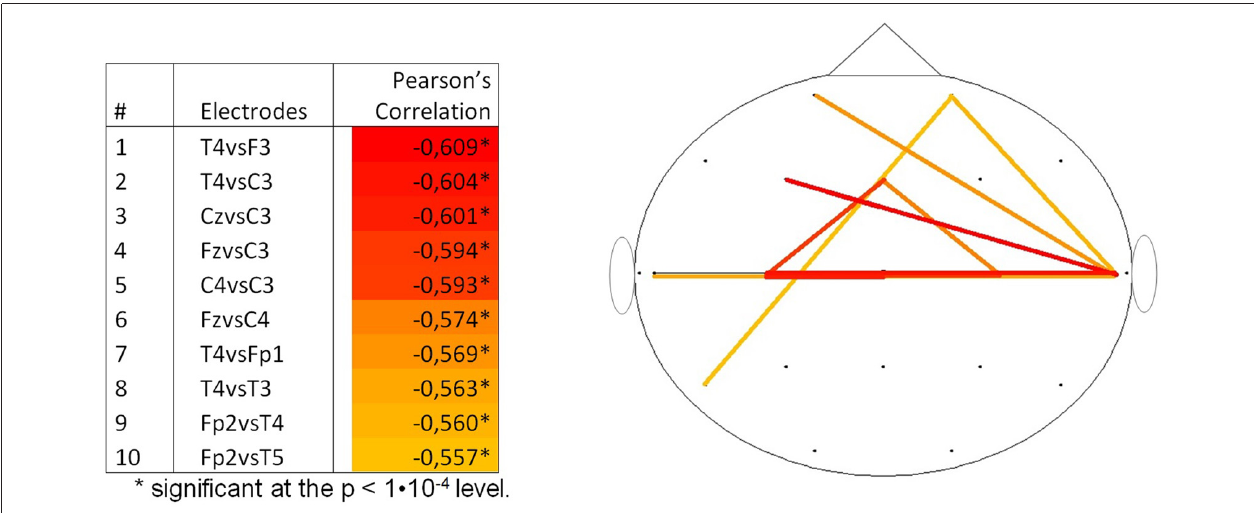
FIGURE 4 | Top 10 correlations per couple of channels between pwPLI and PMA for the delta frequency band ( N = 131). PMA = postmenstrual age, pwPLI = pair wise phase lag index.